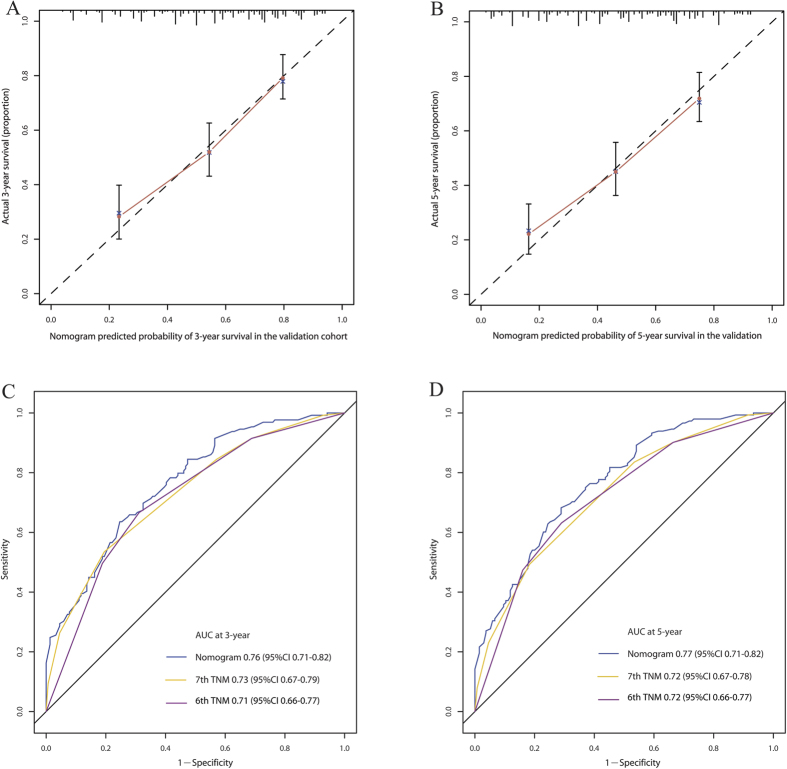
The calibration curve for predicting patient survival at 3-year (A) and 5-year (B) in the validation cohort.Time-dependent receiver operating characteristic (ROC) curves by nomogram, 6th AJCC-TNM staging system and 7th AJCC-TNM staging system for 3-year (C) and 5-year (D) OS in the validation cohort.